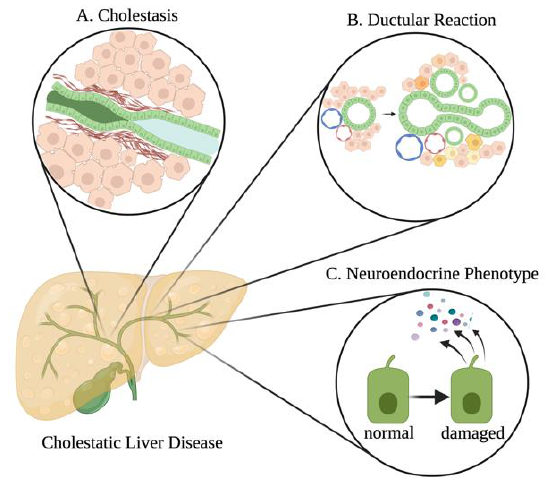
Figure 3. Histopathology of bile duct damage. Different bile duct damages associated with cholestatic liver diseases. ( A ) Following bile duct damage, stricturing of the bile ducts can occur from various processes, including significant peribiliary fibrosis. This stricturing can lead to cholestasis (i.e., blockage of drainage of bile from the liver). ( B ) Cholestatic injury can lead to ductular reaction, which can be accompanied by enhanced biliary inflammation and fibrosis. ( C ) Following damage, cholangiocytes can enter a neuroendocrine phenotype, whereby they increase their synthesis and secretion of various growth factors, neurohormones, cytokines, chemokines, and other factors that can modulate liver damage through autocrine and paracrine signaling mechanisms. Image made with BioRender